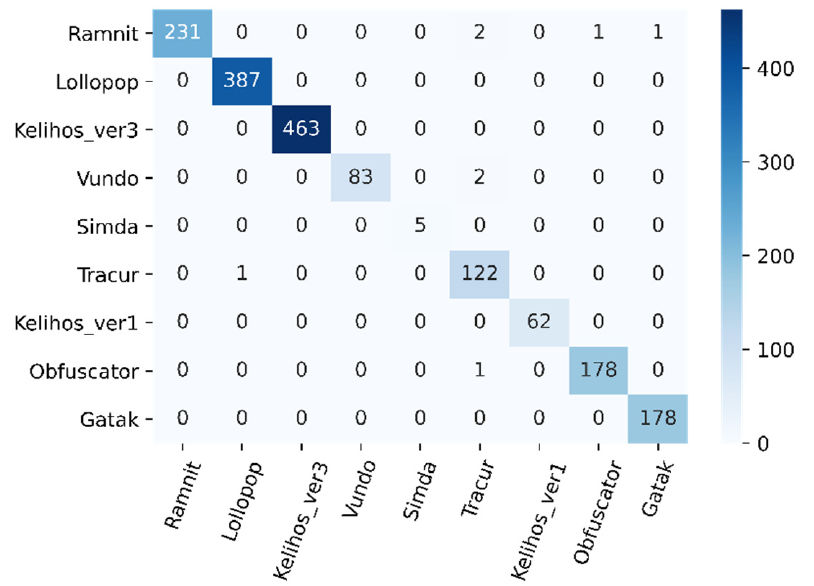
Figure 6. Confusion matrix of malware family detection. (On Dataset A.)